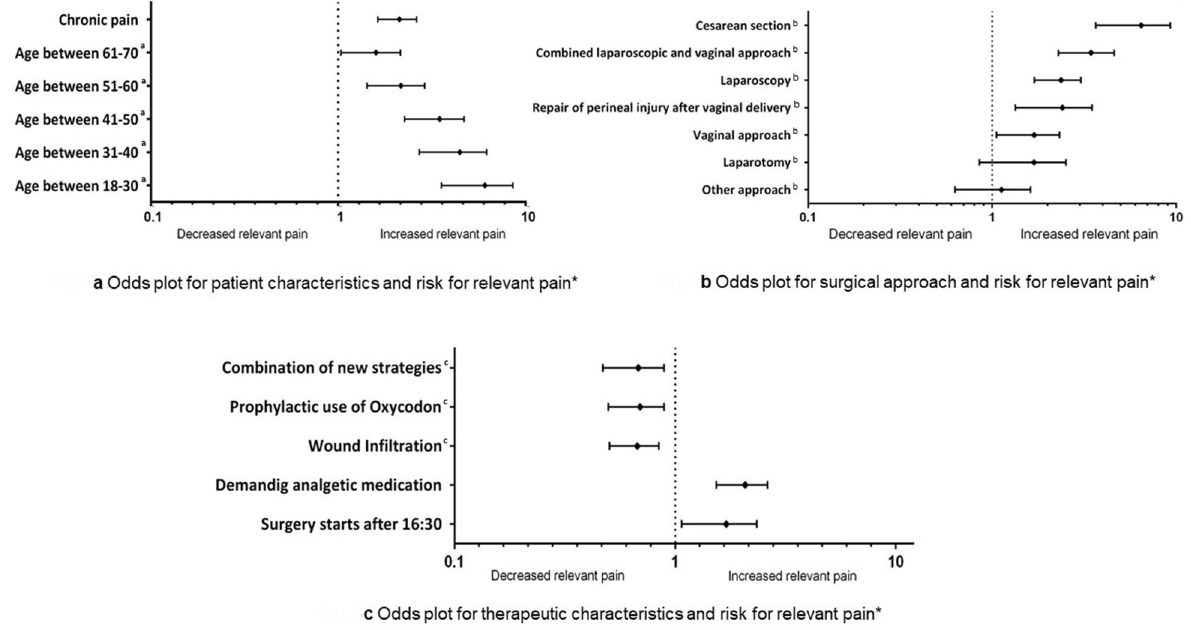
Figure 3. Association between risk factors and risk of increased pain. Binary logistic regression analysis adjusted by age, chronic pain, surgical approach, time point of surgery, use of wound infiltration, prophylactic oxycodone, opioids and epidural catheter. Reference variables: ( a ) age > 71 years; ( b ) breast surgery; ( c ) standard care.